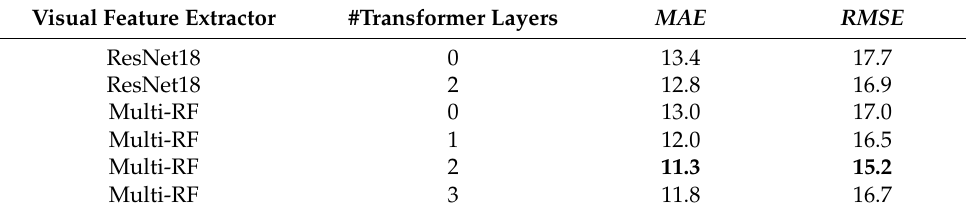
Table 3. Comparison of models with different CNNs and number of transformer layers on Yosemite Tree Dataset for block size 960 × 960. The models are tested on the union of Region A and Region C. When #transformer layers = 0, the CNN features are linearly projected to the predicted density map, otherwise, the density map is generated by DMG. The bold numbers are the lowest values in each